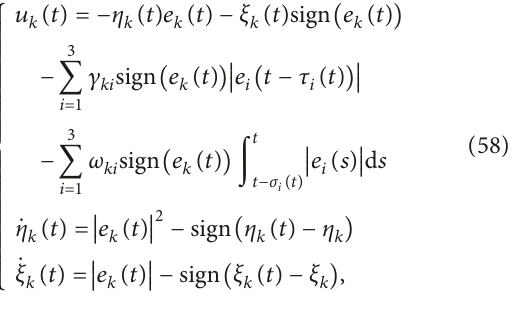
Figure 6: (a) Trajectories of x ( t ) and y ( t ) for drive-response system without controller; (b) trajectories of x 1 1 ( t ) and y ( t ) for drive-response system without controller; (d) trajectories of response system without controller; (c) trajectories of x 3 3 ( t ) ,e ( t ) and e ( t ) for drive-response system without e 1 2 3